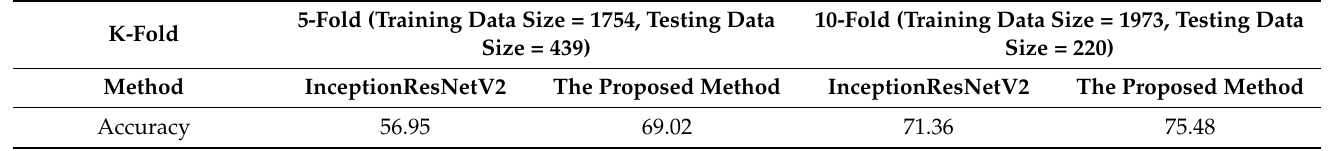
Table 4. Comparison of accuracy between the proposed method and InceptionResNetV2. 5-Fold (Training Data Size = 1754, Testing Data 10-Fold (Training Data Size = 1973, Testing Data K-Fold Size = 439) Size =